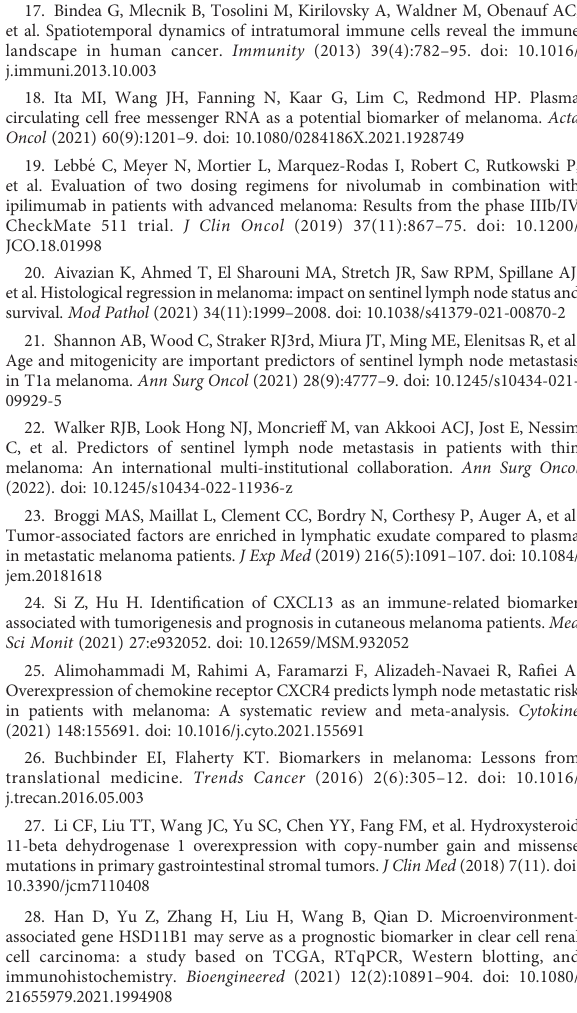
prediction. Kaplan − Meier plot for the expression of (D) HSD11B1, (E) NDRG1 and (F) CDCA3. The hazard ratios (HRs) were evaluated using Cox proportional hazard models.OS: overall survival; ROC curve:receiver operating characteristic curve. SUPPLEMENTARY FIGURE 3 The prognostic value of CCP-related genes (disease-speci fi c survival) in diverse cutaneous melanoma (A) . Forrest plot showing the results of multivariate Cox regression analysis. (B) . Nomogram integrating the 3 CCP-related gene-based riskscore, N stage, race, and Breslow depth. (C) . CalibrationplotsofthenomogramforevaluatingtheprobabilityofOSat2 and 4 years. OS, overall survival. SUPPLEMENTARY FIGURE 4 TheexpressionlevelsofCDCA3indifferentcancertypesandincutaneous melanoma. (A) Increased or decreased CDCA3 expression in different cancer types compared with normal tissues in TCGA and GTEx databases. (B – D) The expression levels of CDCA3 in cutaneous melanoma. (E) ROC